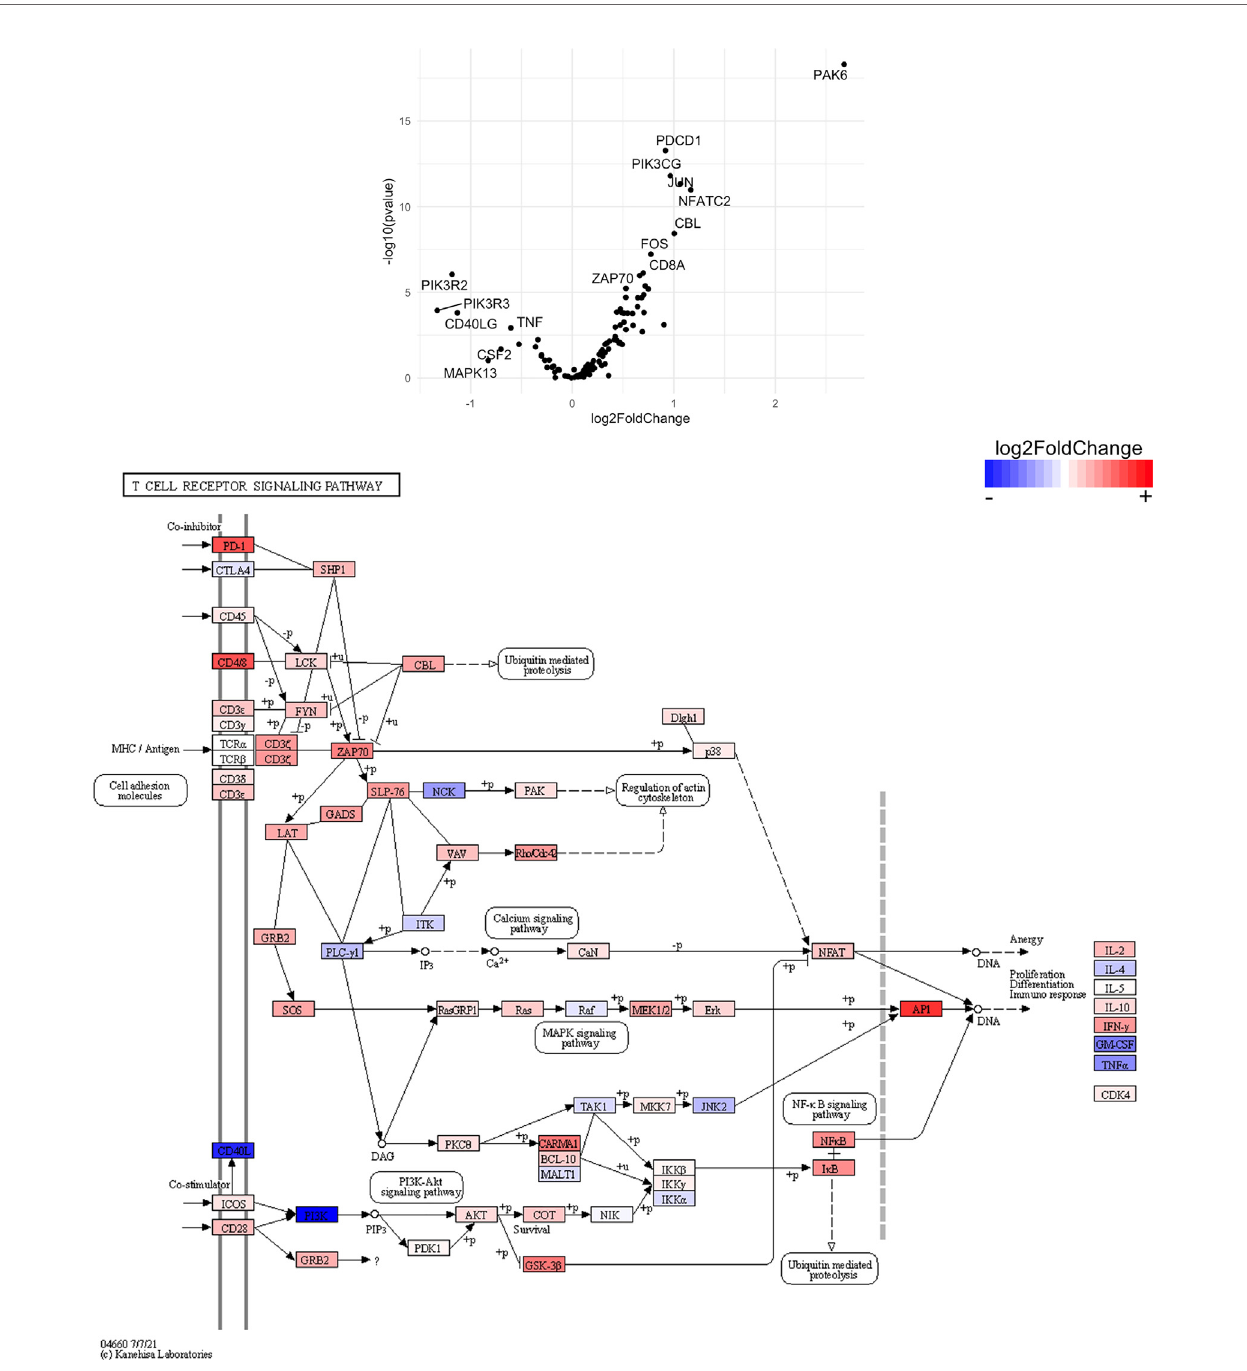
FIGURE 15 | Genes related to T cell receptor signaling are enriched in CD8 + T cells from the CNS of microglia-de fi cient B6J mice compared to microglia-de fi cient SJL mice. C57BL/6J and SJL/J mice were treated with a PLX5622-supplemented diet seven days prior to i.c. TMEV infection and sacri fi ced at 6 DPI for analysis (n = 10 mice per group). Volcano plot of RNA-seq transcriptome data, censoring CD4 as an outlier that may represent contamination in CD8 + T cell enrichment (see Supplemental Data ), and KEGG map display T cell receptor signaling-related gene expression in enriched CD8 + T cells from the CNS of microglia-de fi cient C57BL/ 6J mice relative to microglia-de fi cient SJL/J